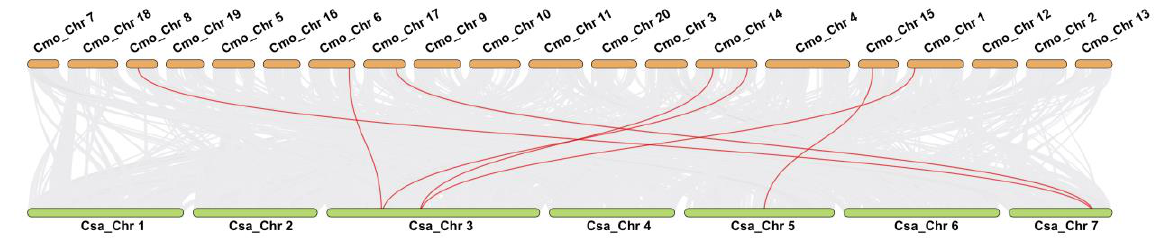
Figure 4. Chromosome localization of duplicated CmoGS and CsaGS gene members in pumpkin and cucumber. The red lines represent the colinear genes.